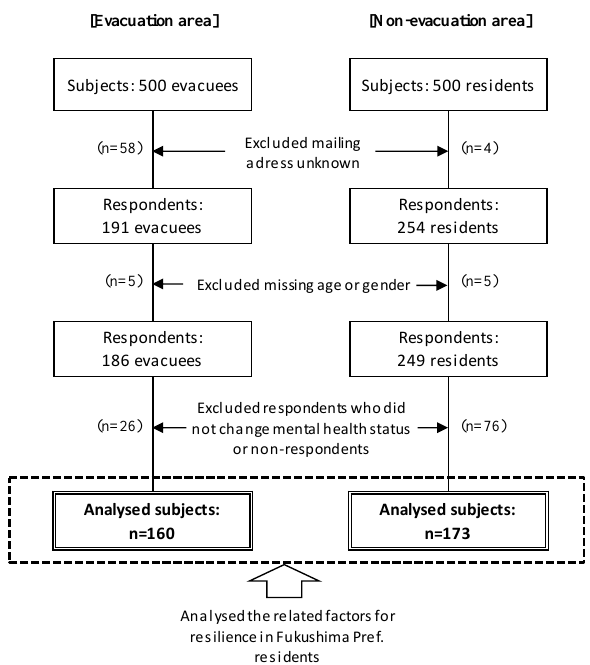
Figure 3. Sample selection in the evacuation and non-evacuation area: Among the 1000 subjects, 191 evacuees in the evacuation area and 254 residents in the non-evacuation area responded to the questionnaire. After excluding respondents who were missing age and gender information, and who did not change their mental health status or non-respondents, we analyzed 160 subjects in the evacuation area and 173 subjects in the non ‐ evacuation area.